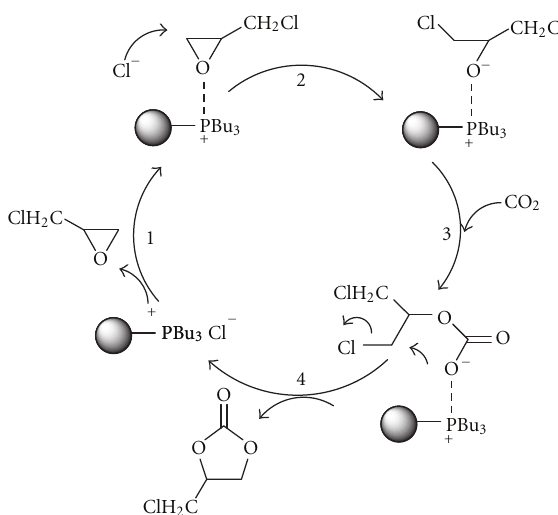
S 2: Proposed mechanism for PS-QPS catalyzed cycloaddi- with epoxides. tion of CO 2